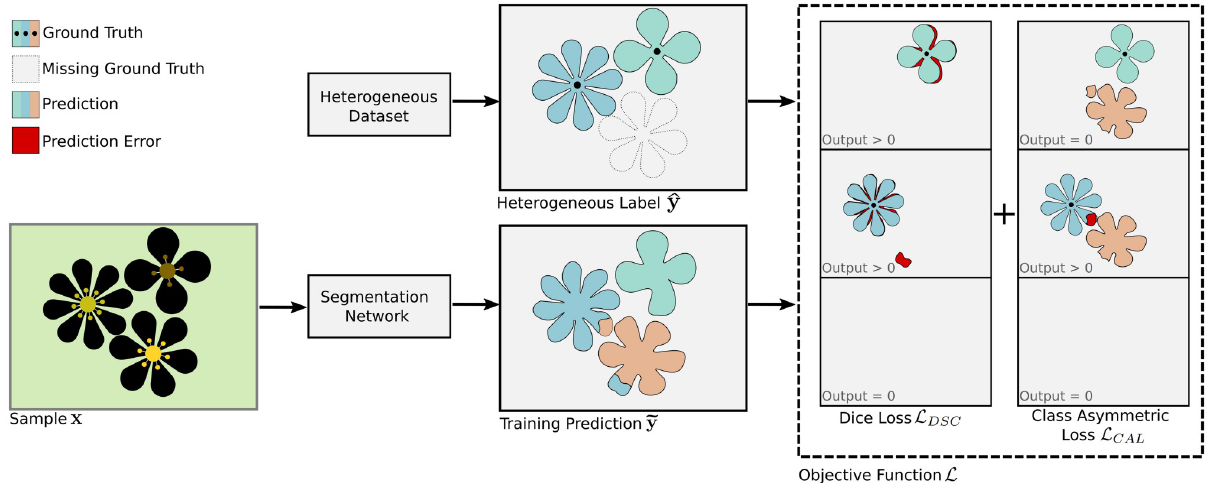
Fig 1. Visualization of the combined objective function. An exemplary sample x is fed into the network, which outputs a training prediction ^ y . Each class is denoted with a unique color. The corresponding ground truth label ~ y is missing the class on the lower right. The dotted line marks where the label would be in the sample. The dashed box on the right denotes L , with the output for both objective functions L marked as red areas. The number in the lower-left corners indicates the approximate output for the respective objective function. Since there is a prediction error in both given classes, the Dice loss will output a value L > 0 for them and 0 for the unlabeled class since it cannot make a statement without the ground truth mask. The class asymmetric loss will only output a value L > 0 if an unlabeled class’s predicted segmentation mask intersects with a given class’s ground truth mask. Since the network predicted a small portion of the unlabeled class as part of the class in the center-left, the output will be L > 0 for this class. For the other labeled class, no intersection occurred, and hence the output is 0. Since the unlabeled mask does not contain a ground truth, it is not evaluated by the class asymmetric loss, which will result in an output of